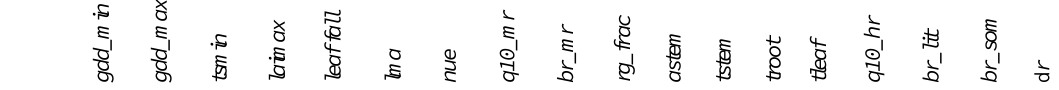
Table 3. Distance correlation factors for D ST . The diagonal blocks are marked according to the process the parameters contribute to; see also Fig. 2 and Table 1. The entries in the diagonal block show dependencies between parameters from the same process, while the entries in the off-diagonal block show dependencies between parameters from different